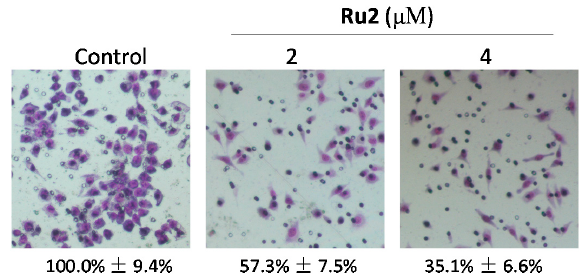
Figure 3. Effects of Ru2 on HepG2 cell invasion by using Transwell Boyden assay. Cells were exposed to different Ru2 concentrations for 24 h, stained with Giemsa solution, and photographed using a phase-contrast microscope (200×, Nikon TS100). Values under the images indicate the invasion ability of the cells.